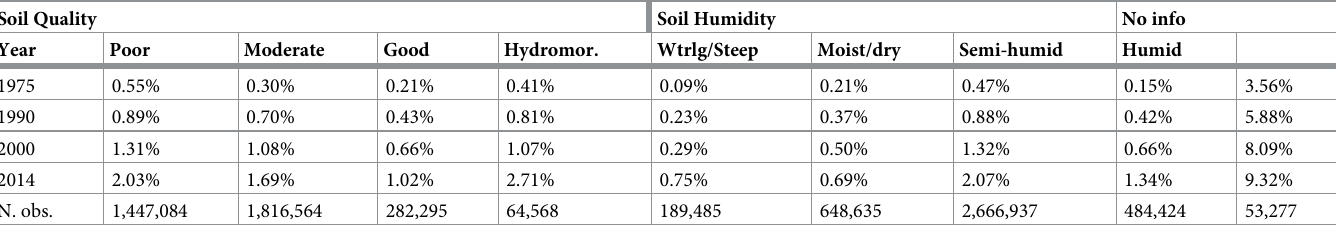
Table 4. Breakdown of built-up proportion by agro-ecological zones.